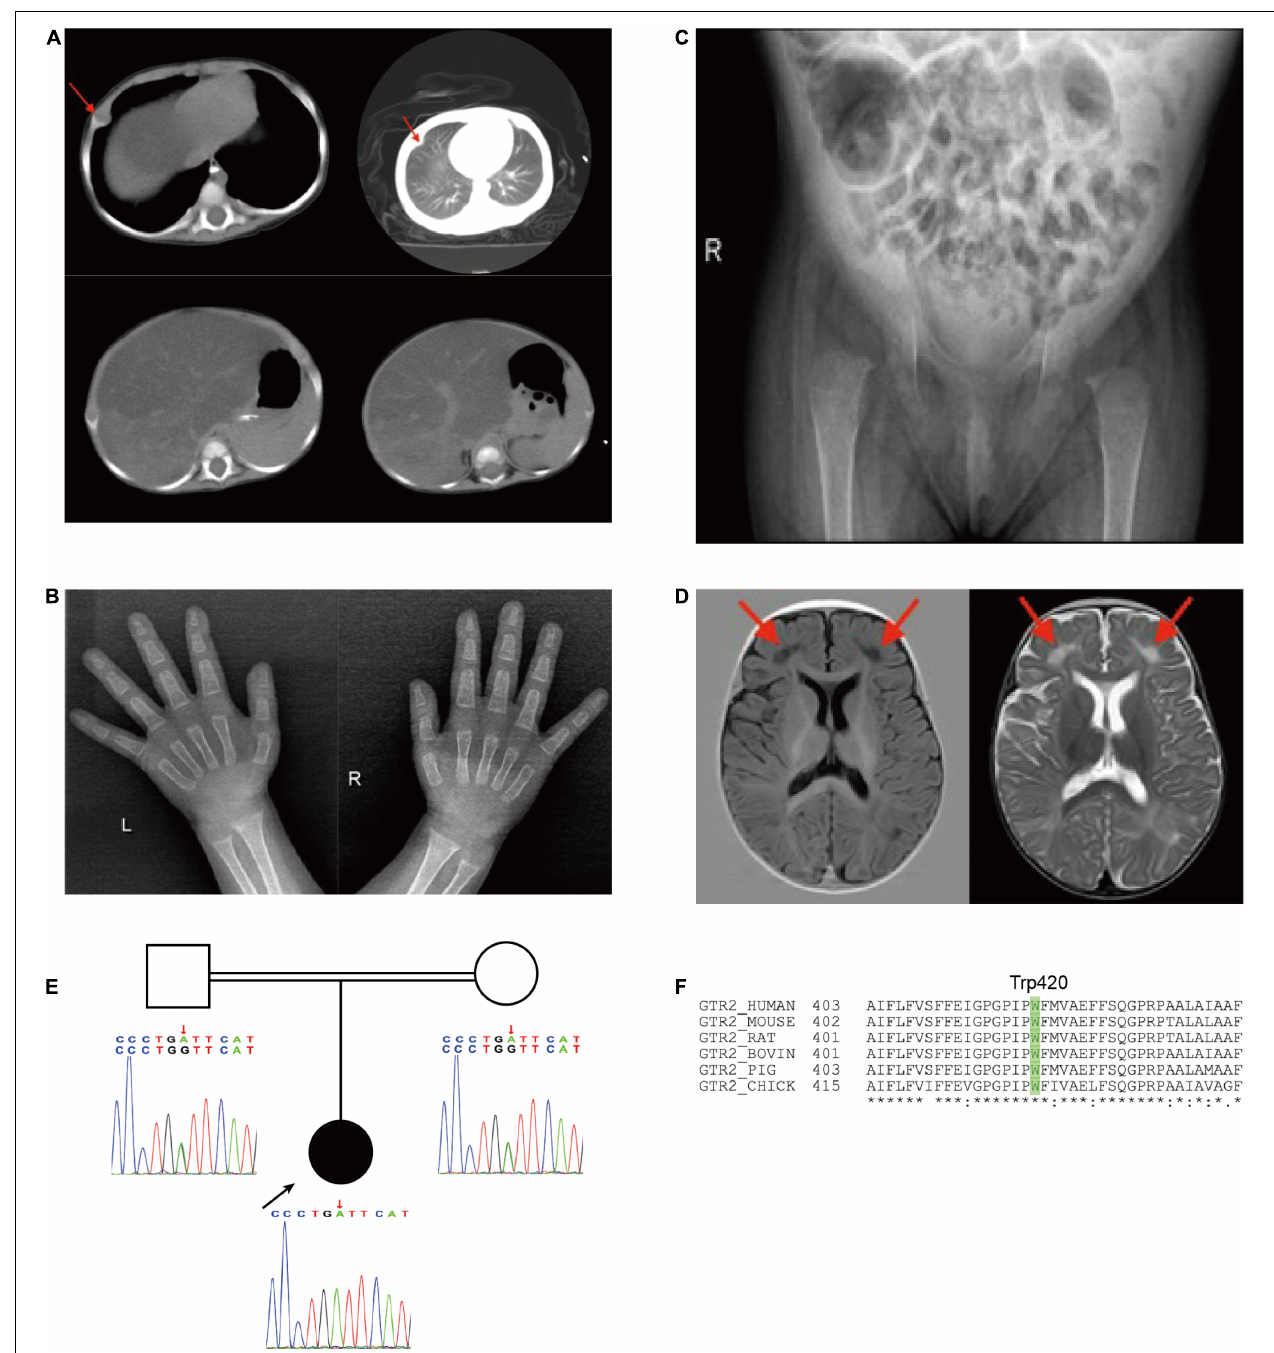
FIGURE 3 | (A) Chest CT showing that the cartilaginous end of the rib was enlarged; Abdominal CT showing an uneven decrease of liver density; (B) X-ray of both hands and (C) X-ray of hip joint indicated rickets; (D) brain MRI, low signal on T1 and high signal on T2. (E) Pedigree showing SLC2A2 homozygous mutations in the child. (F) Trp420 is conserved across